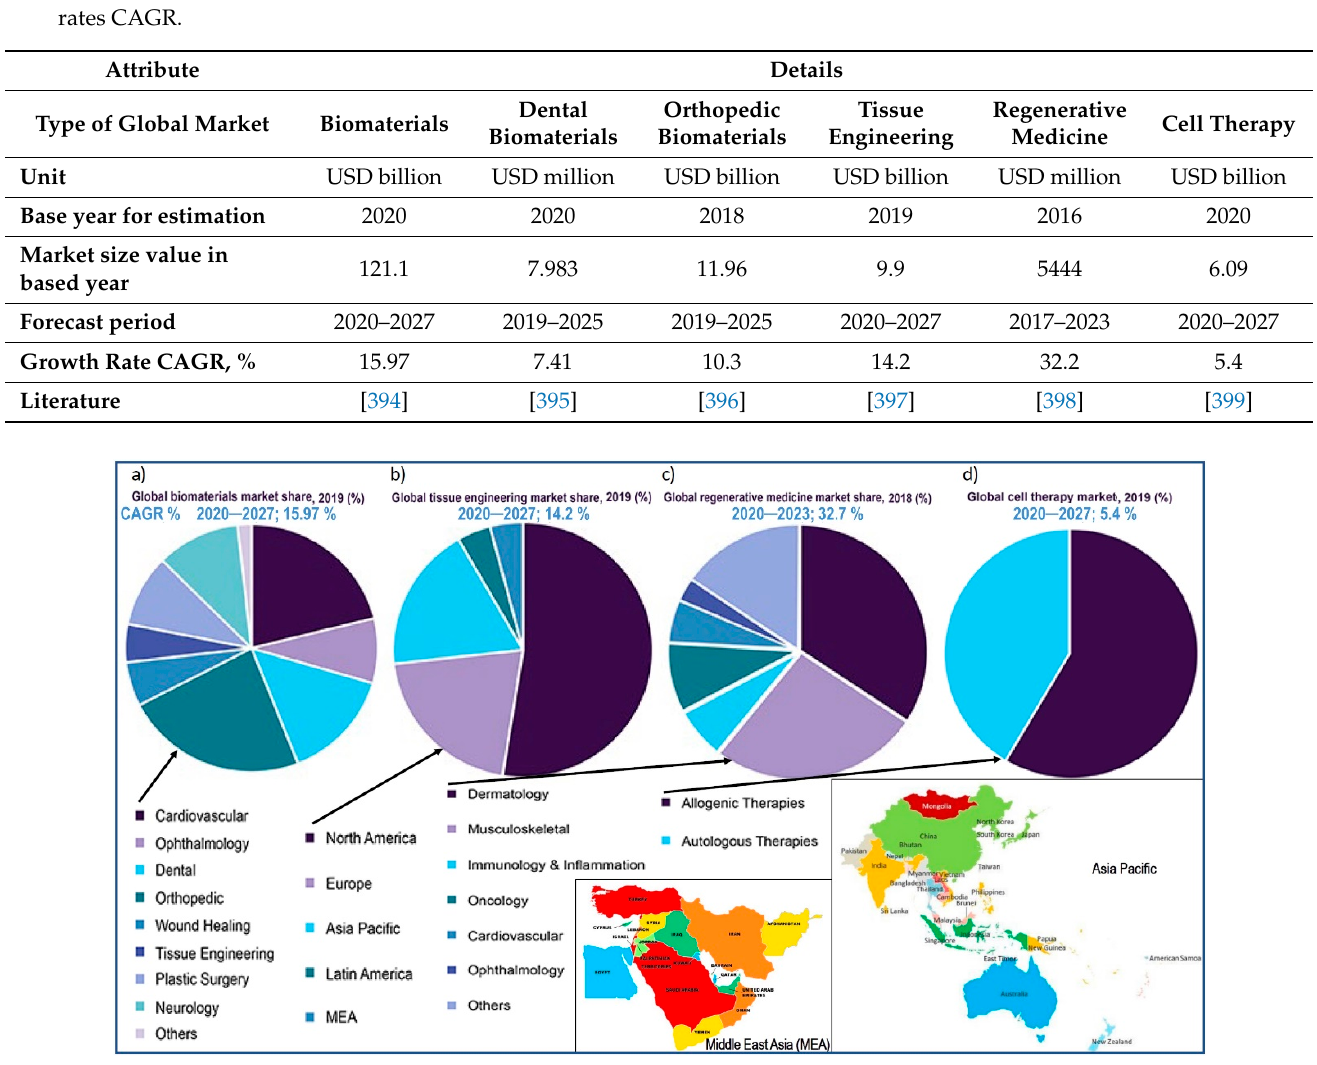
Figure 36. The structure of global markets due to ( a ) the use of biomaterials for the treatment of various diseases; ( b ) involvement of individual geographic regions in tissue engineering technologies; ( c ) the suitability of regenerative medicine methods for treating multiple diseases; ( d ) the contribution of allogeneic and autologous cell-mediated therapies.